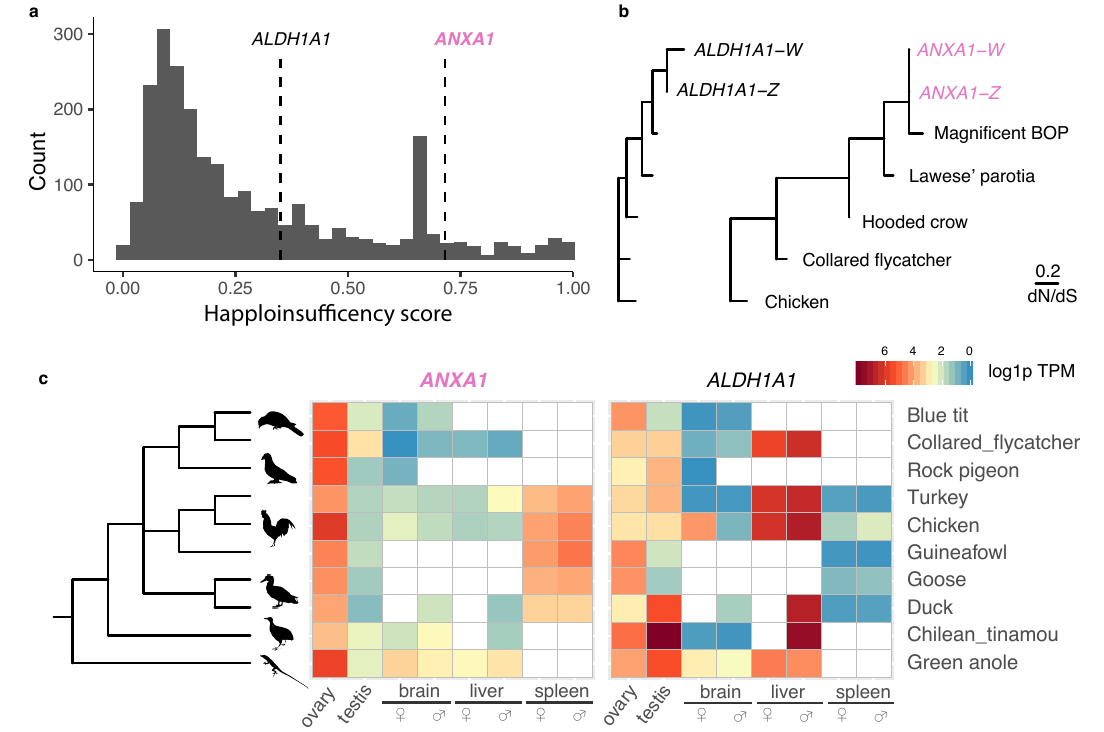
Figure 2. Transposed genes in birds-of-paradise are likely under evolutionary constraint ( a ) The distribution of predicted haploinsu ffi ciency scores of human orthologs of all Z-linked genes, marked with ZTR genes ALDH1A1 and AXA1 by vertical dashed lines. ( b ) The phylogenetic tree with the branch lengths scaled by the ratios of nonsynonymous substitution rate to synonymous substitution rate (dN / dS). No nonsynonymous substitutions have been detected for ANXA1 . ( c ) The expression of ALDH1A1 and ANXA1 across four di ff erent tissues of both male and female in nine birds and one reptile species. The expression levels were log1p (log 1 + TPM) transformed. Species that do not have the tissue transcriptome are denoted with blank